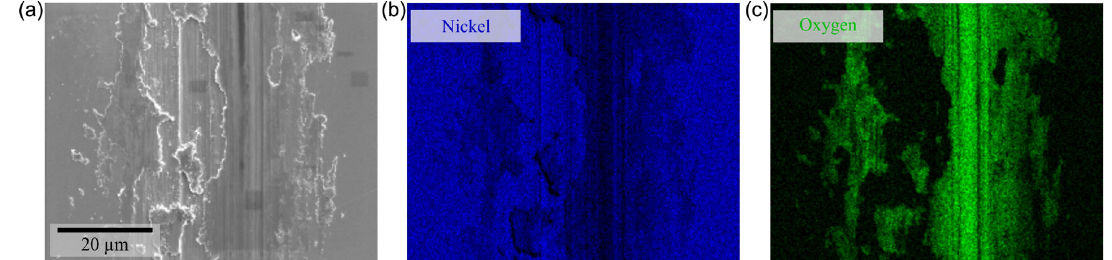
Fig. 4 Wear track after 10 sliding cycles at 1 N of the nc sample. (a) High resolution electron micrograph for (b) corresponding Ni and (c) oxygen EDS concentration maps.